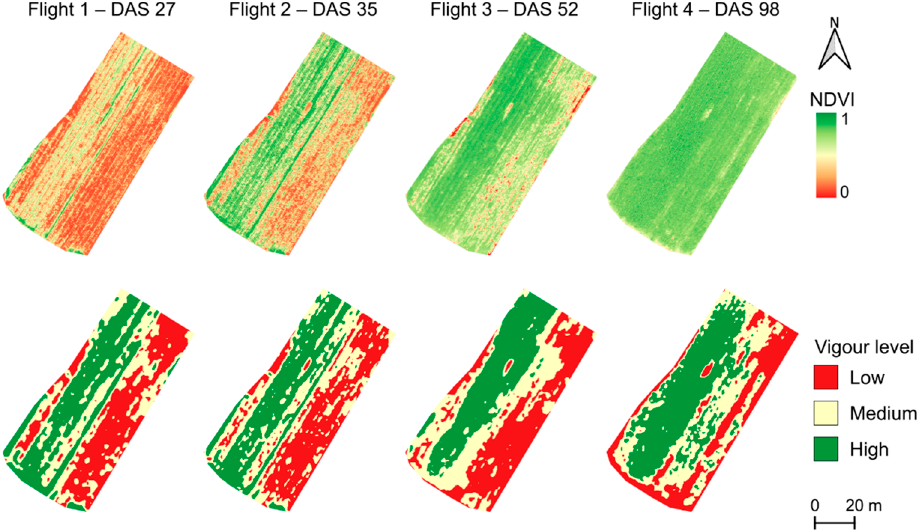
Figure 9. NDVI in the top row and the vigour maps generated by QVigourMap in the bottom row, with three vigour levels (high, medium, and low) considering only vegetation from maize crops.